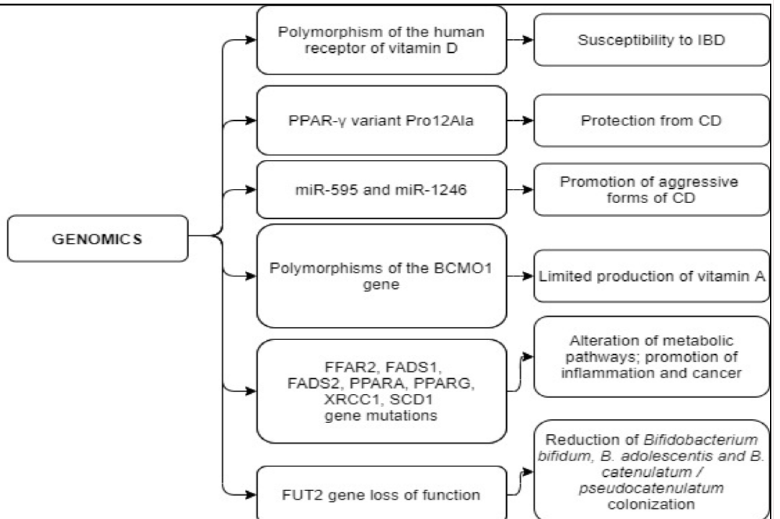
Figure 4. Effects of genetic variation on CD onset and outcomes. Abbreviations: IBD, Inflammatory Bowel Disease; PPAR- γ Peroxisome proliferator-activated receptor gamma; miR-595, MicroRNA 595; miR-1246, MicroRNA 1246; BCMO1, β , β -carotene-15,15 (cid:48) -monooxygenase 1; FFAR2, Free Fatty Acid Receptor 2; FADS1, Fatty Acid Desaturase 1; FADS2, Fatty Acid Desaturase 2; PPARA, Peroxi- some Proliferator Activated Receptor Alpha; PPARG, Peroxisome Proliferator-Activated Receptor Gamma; XRCC1, X-ray Repair Cross Complementing 1; SCD1, Stearoyl-CoA Desaturase-1; LC- PUFA-omega-3 and omega-6, Long Chain Polyunsaturated Fatty Acids-omega-3 and omega-6; FUT2, Fucosyltransferase